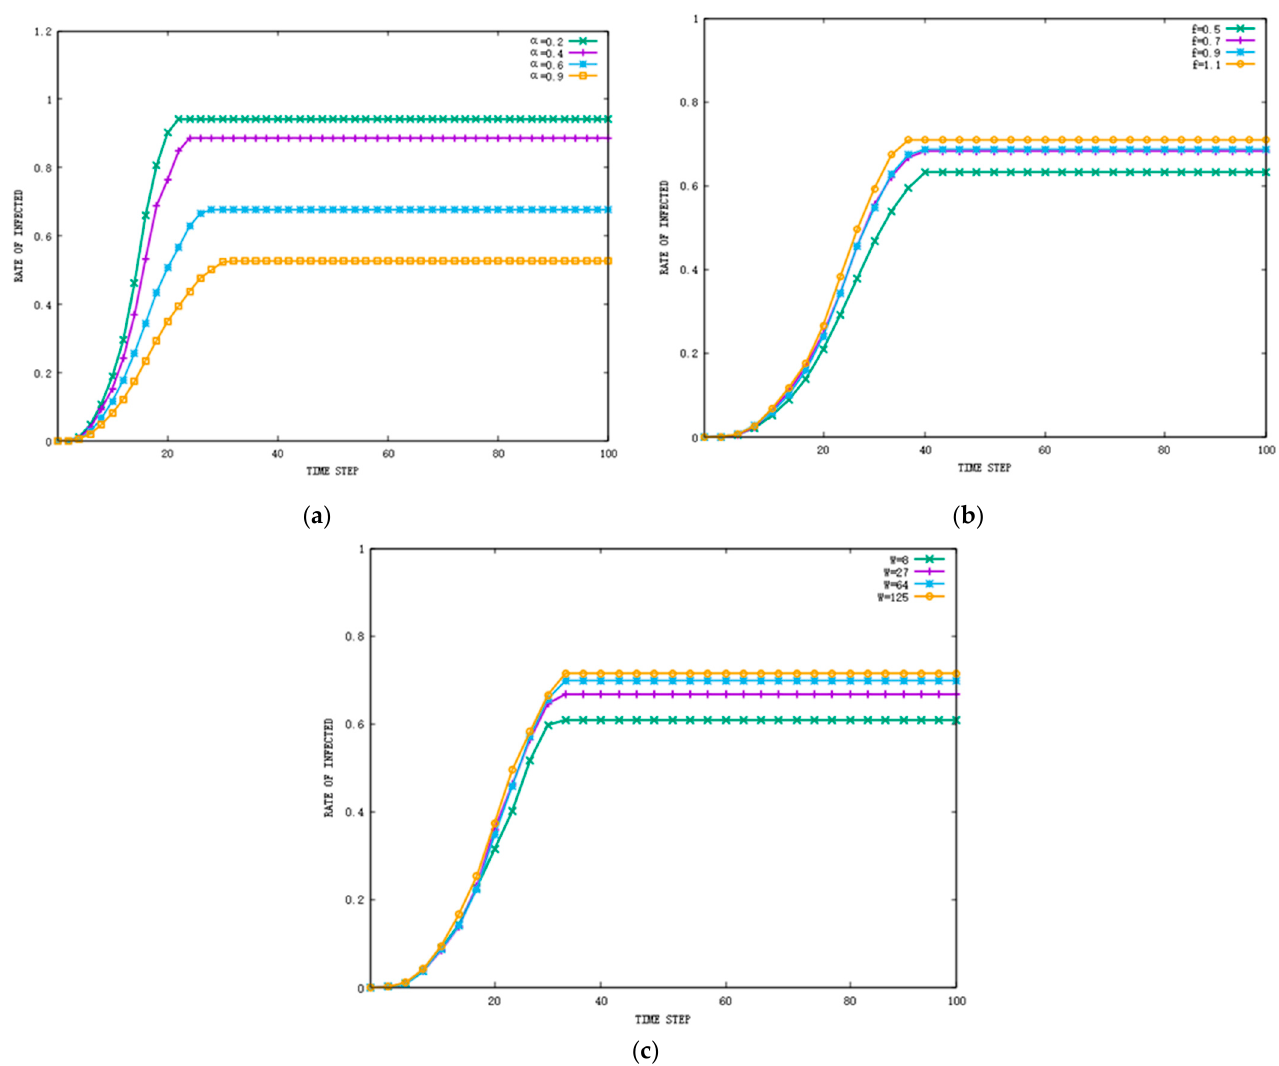
Figure 4. The impact of individual features on the rate of infected individuals in the Facebook dataset: ( a ) the impact of α on the rate of infected individuals, ( b ) the impact of f on the rate of infected individuals, and ( c ) the impact of W on the rate of infected